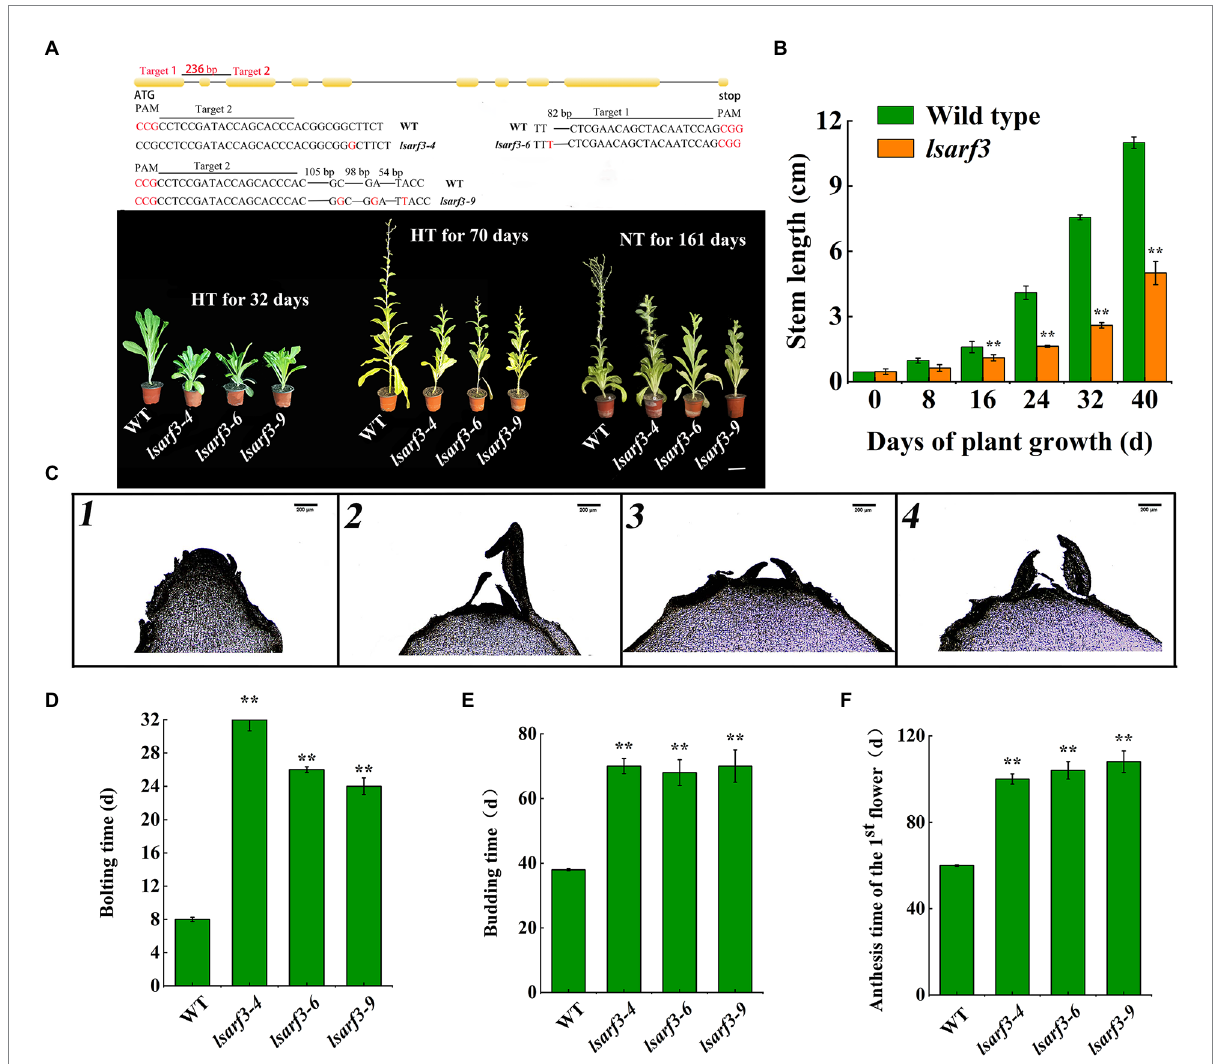
FIGURE 2 Knockout of LsARF3 in lettuce via CRISPR-Cas9. (A) Phenotypes of WT and lsarf3 mutant lines growing in high temperature condition for 32 and 70 days, and in normal temperature condition for 161 days, Bar = 6 cm. HT represents high temperature condition. (B) Stem length change of WT and lsarf3 mutant lines. (C) Flower bud differentiation of stem apex in high temperature condition for 32 days. 1.WT; 2. lsarf3-4 ; lsarf3-6 ; 3. lsarf3-9. Bar =200 μ m. (D) Bolting time of WT and lsarf3 mutants. (E) Budding time of WT and lsarf3 mutants. (F) Anthesis time of the 1st flower in WT and lsarf3 mutants. Significant differences were tested by Student’s t-test (**indicates p <